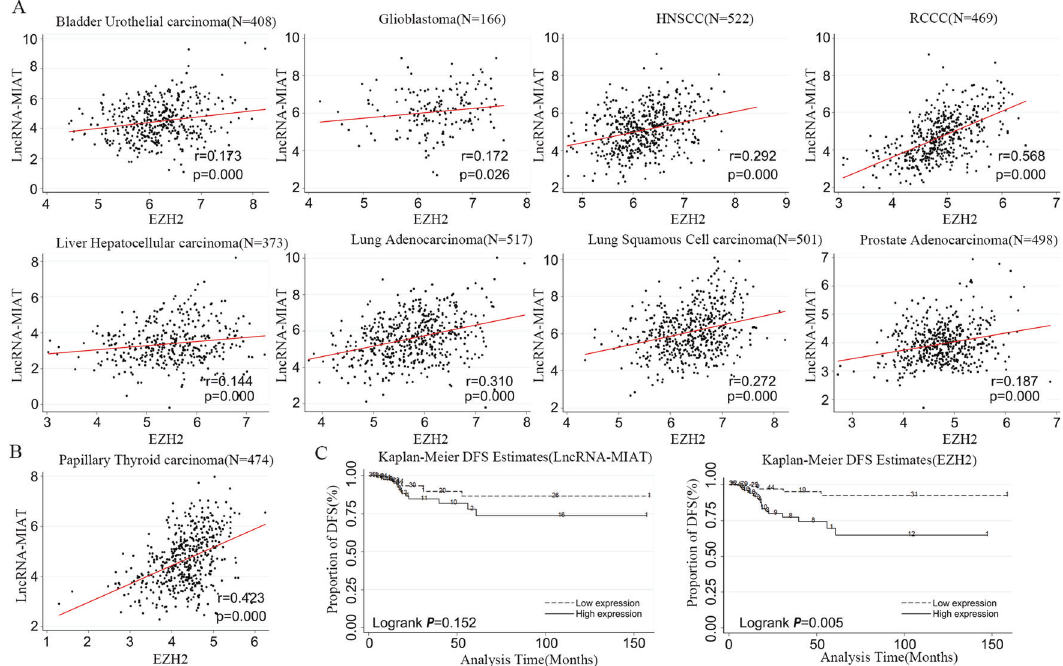
Fig. 4 The correlation between lncRNA-MIAT and EZH2 validated by data from TCGA. A Regression analysis between lncRNA-MIAT and EZH2 in urothelial carcinoma, glioblastoma, head and neck squamous cell carcinoma (HNSCC), renal clear cell carcinoma (RCCC), hepatocellular carcinoma, lung adenocarcinoma, lung squamous cell carcinoma, and prostate adenocarcinoma. lncRNA-MIAT expression was positively correlated with EZH2 expression ( P < 0.01). B Regression analysis between lncRNA-MIAT and EZH2 in PTC. C The Kaplan – Meier DFS estimate curves of lncRNA-MIAT and EZH2.